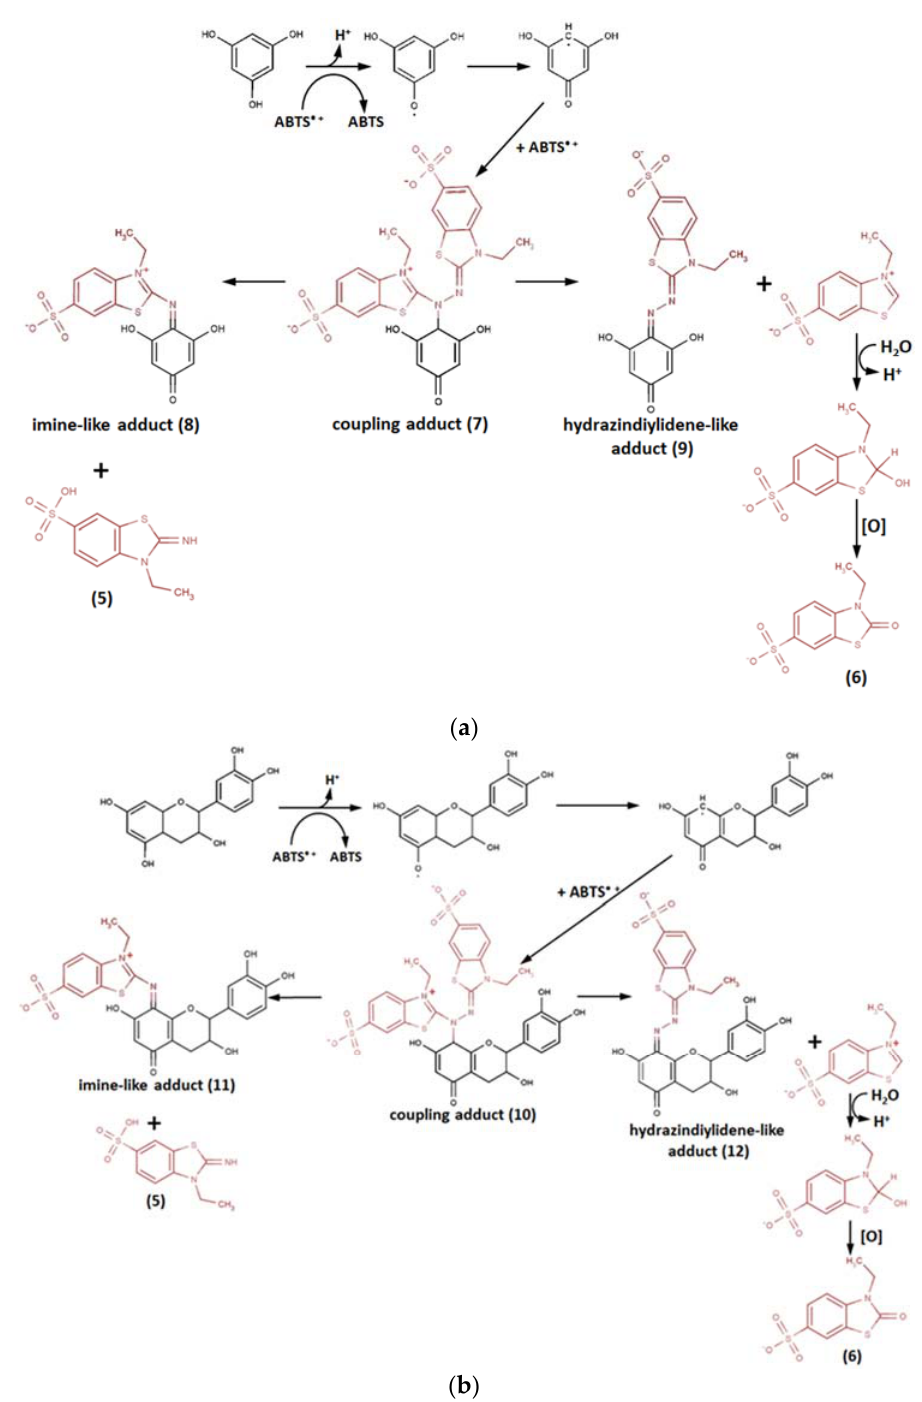
Figure 5. Reaction pathways of ABTS •+ with ( a ) phloroglucinol and ( b ) catechin [83]. Copyright 2006, adapted with permission from Elsevier.